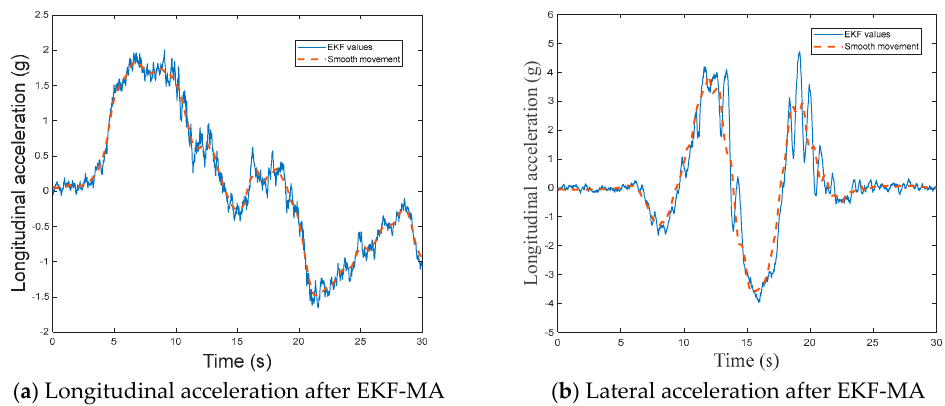
Figure 17. Longitudinal and lateral acceleration filtered by the EKF-MA algorithm. Using LM-MMSOFNN, the road adhesion coefficient and tire force of the four wheels were obtained and are shown in Figures 18–21. The estimation errors of LM-MMSOFNN and K-means-RBF are the average of five calculations (see Tables